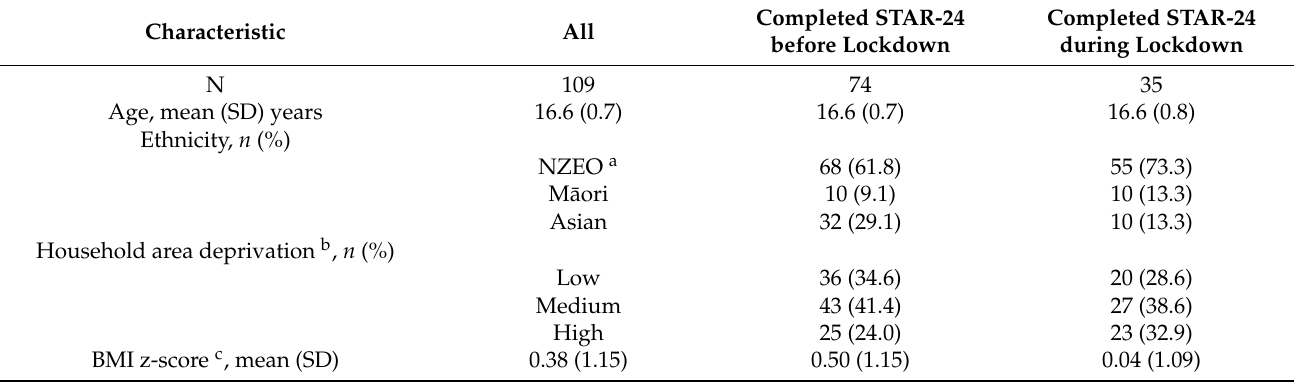
Table 1. Characteristics of the samples ( n =